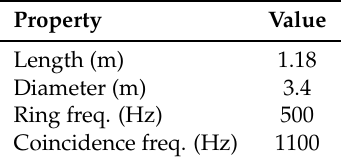
Figure 2. From the top to the bottom: ( i ) finite-element method (FEM) model; ( ii ) hybrid model; and ( iii ) acoustic coupled model for the IS01 interstage. Table 1. Geometrical characteristics and theoretical estimates of dynamic frequencies for the IS01